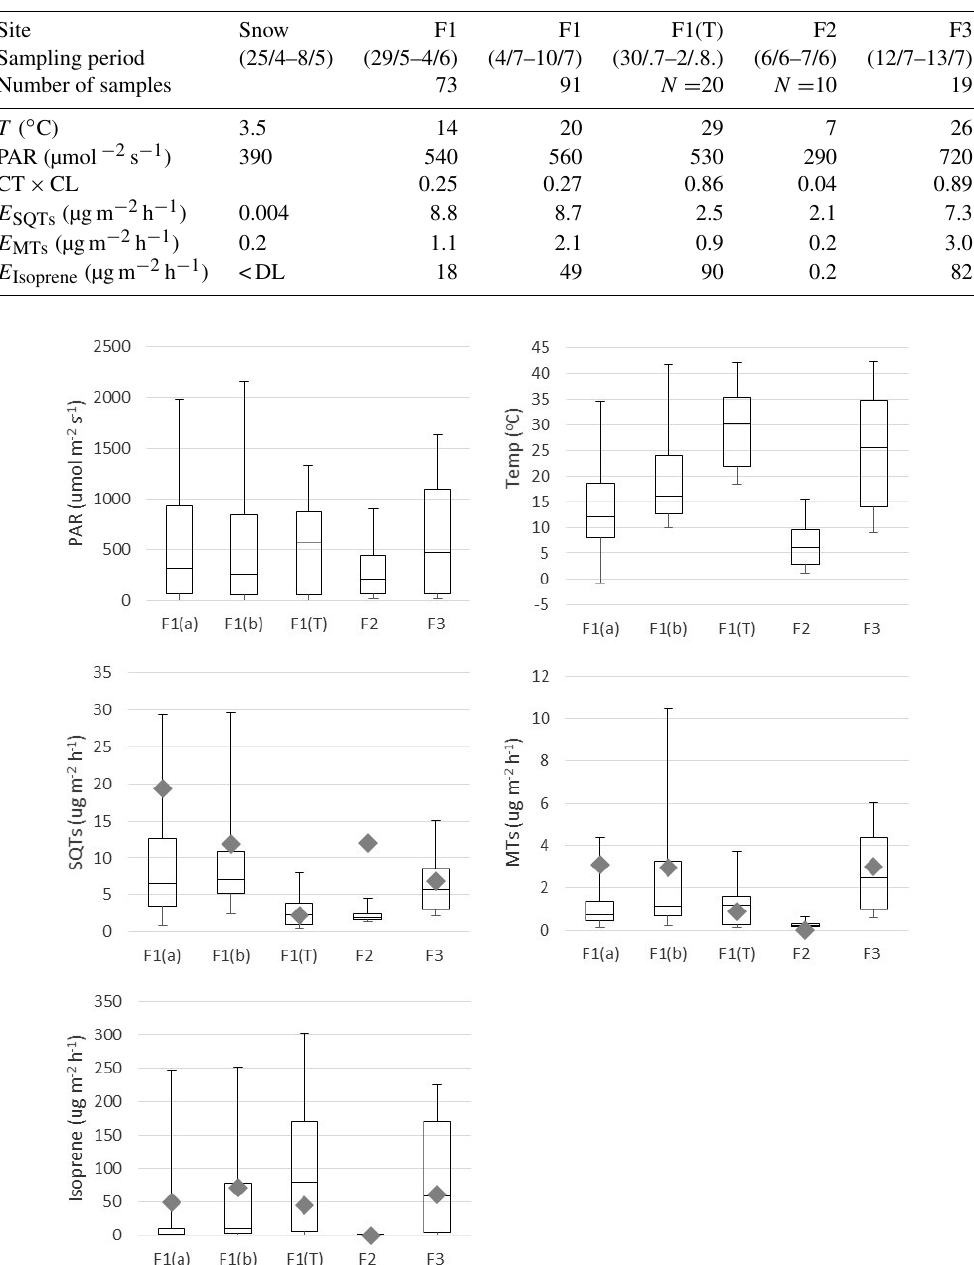
Table 1. Mean chamber temperature ( T ), photosynthetically active radiation (PAR), temperature and light activity coefficient (CT × CL, Guenther et al., 1993) and emission rates ( E ) of monoterpenes (MTs), sesquiterpenes (SQTs) and isoprene during the various sampling periods. F1(a): frame 1; F2: frame 2; F1(b): frame 1; F3: frame 3; F1(T): tube samples from frame 1. (<DL: below detection limit).